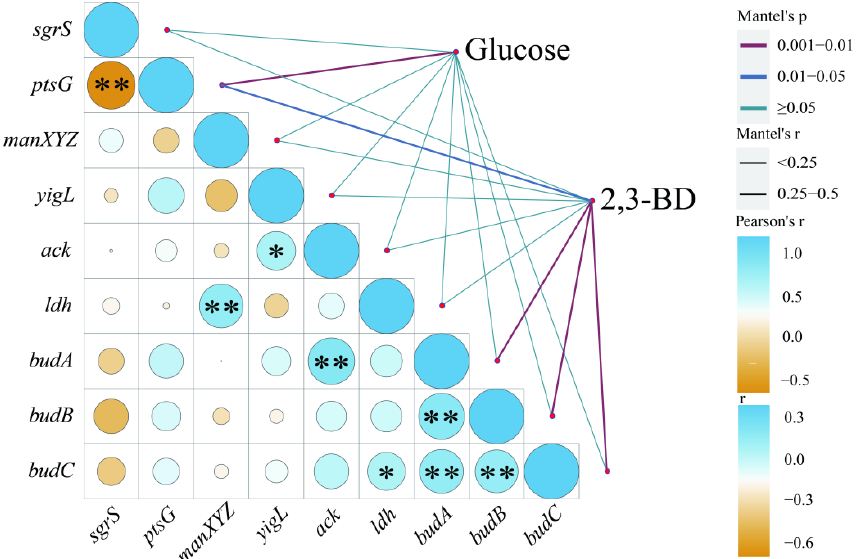
Figure 6. The lower left part of the figure is the heat map of correlation analysis between the relative expression levels of each gene at 24, 48, and 72 h. In this part, blue represents positive correlation and yellow represents negative correlation, * indicates p < 0.05; ** indicates p < 0.01. The upper right corner of the graph shows the correlation between each gene and glucose consumption and the yield of 2,3-BD at 24, 48, and 72 h. In this part, red represents p < 0.01 and blue represents p < 0.05, green represents no correlation.